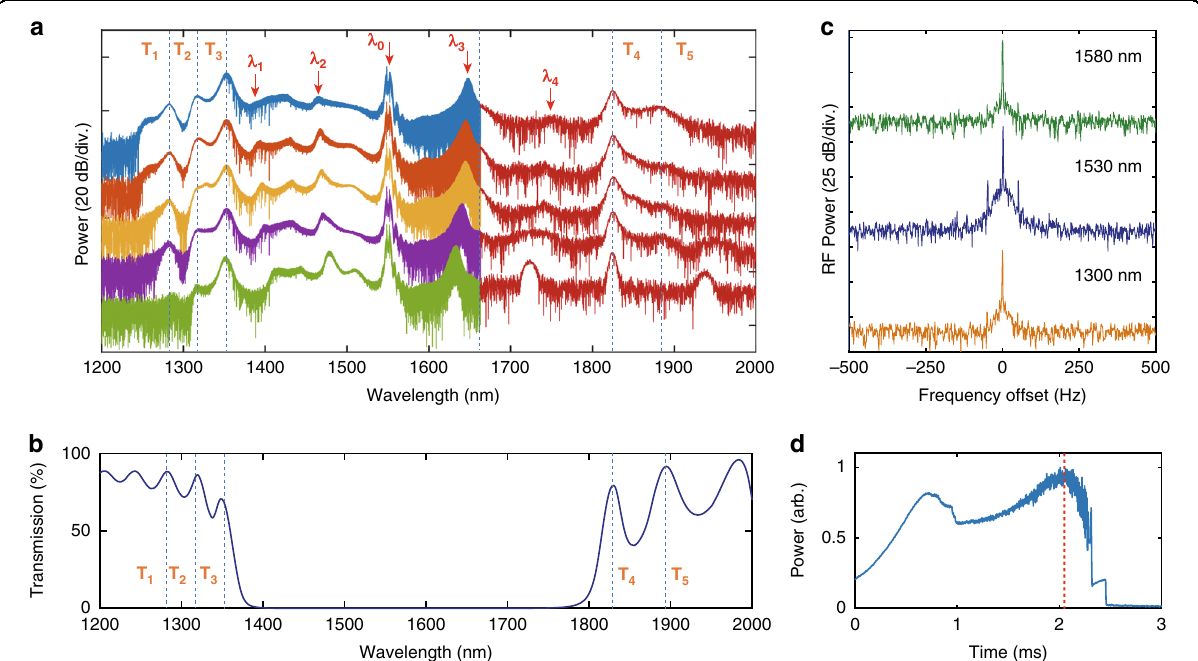
Fig. 4 MI microcombs with 2/3-octave spanning. a Broadband MI microcomb spectra. The corresponding pump power from the bottom (green) to the top (blue) of the spectra are 23.5 dBm, 24.5 dBm, 25 dBm, 25.5 dBm, and 26 dBm. Four residual primary comb envelopes are marked by λ 1 – λ 4 , and the mirror coating induced fi xed peaks are marked by T 1 – T 5 . b Measured transmission spectrum of dielectric mirror coating. The transmission peaks are also marked by T 1 – T 5 . c Repetition-rate beatnote signals of MI microcomb near 1300 nm (yellow), 1530 nm (blue), and 1580 nm (green). d Transmission curve for δ f rep = – 20 kHz and pump power of 26 dBm. The red dashed line marks the measured position of the broadband MI spectrum as shown in blue curve in ( a